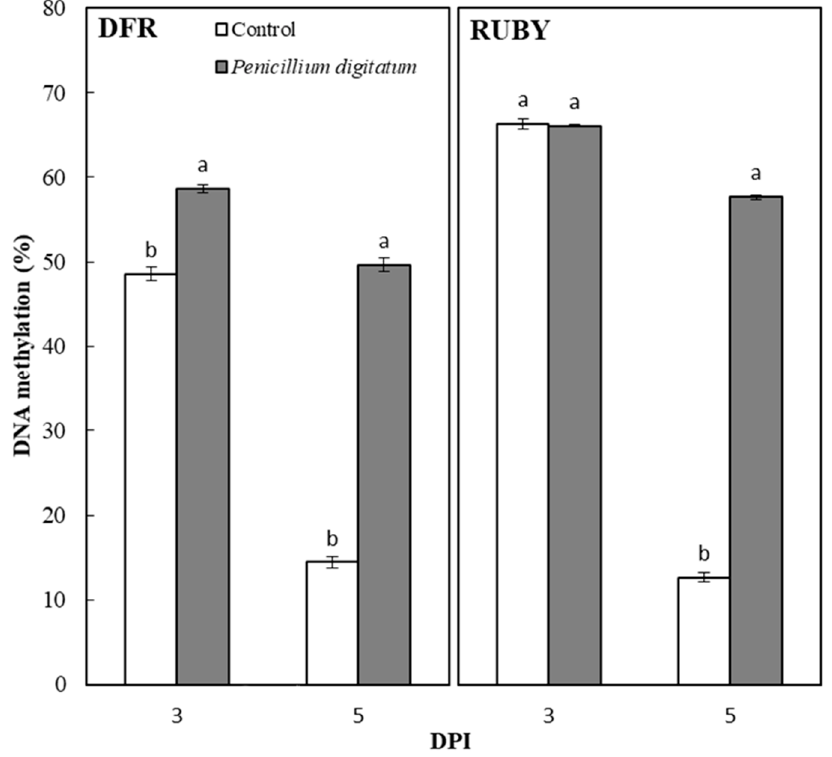
Figure 4. Analysis of the methylation status of both DFR and Ruby promoter regions. Each point represents the mean value of three replications ± SD. Significantly different values, within each sampling time, are indicated by different letters ( p < 0.05).